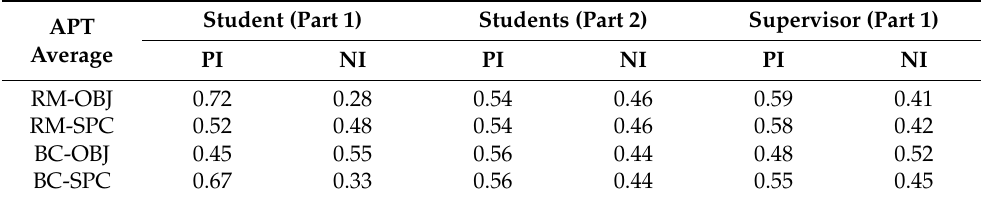
Table 6. Positive and Negative Index for APT Project (Part 1 and 2).